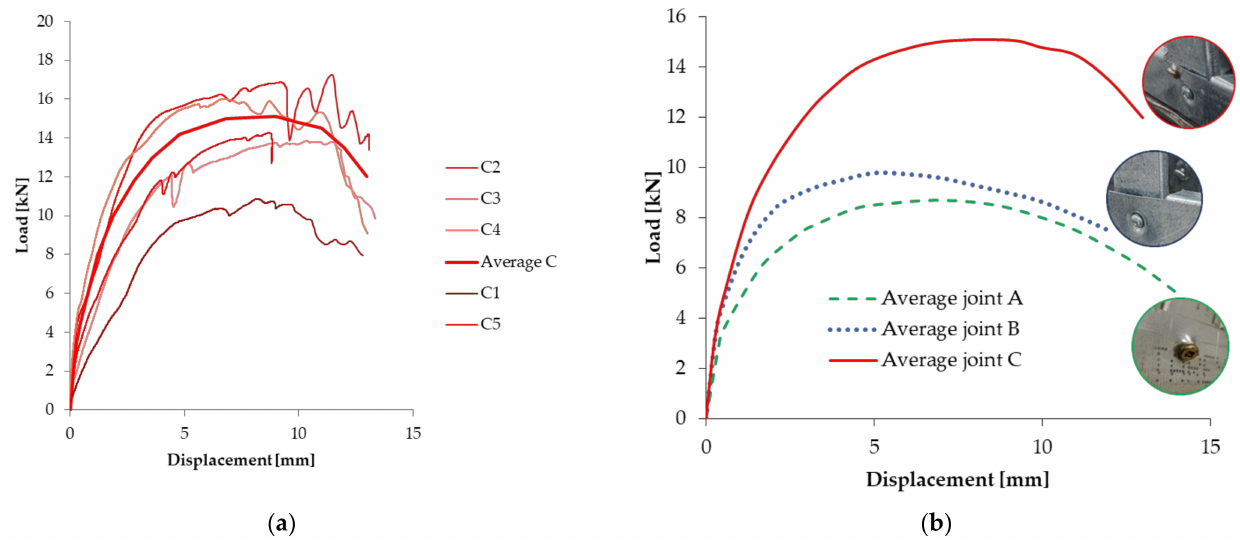
Figure 15. Load–displacement curves: ( a ) joint C; ( b ) Comparison of Average A, B,